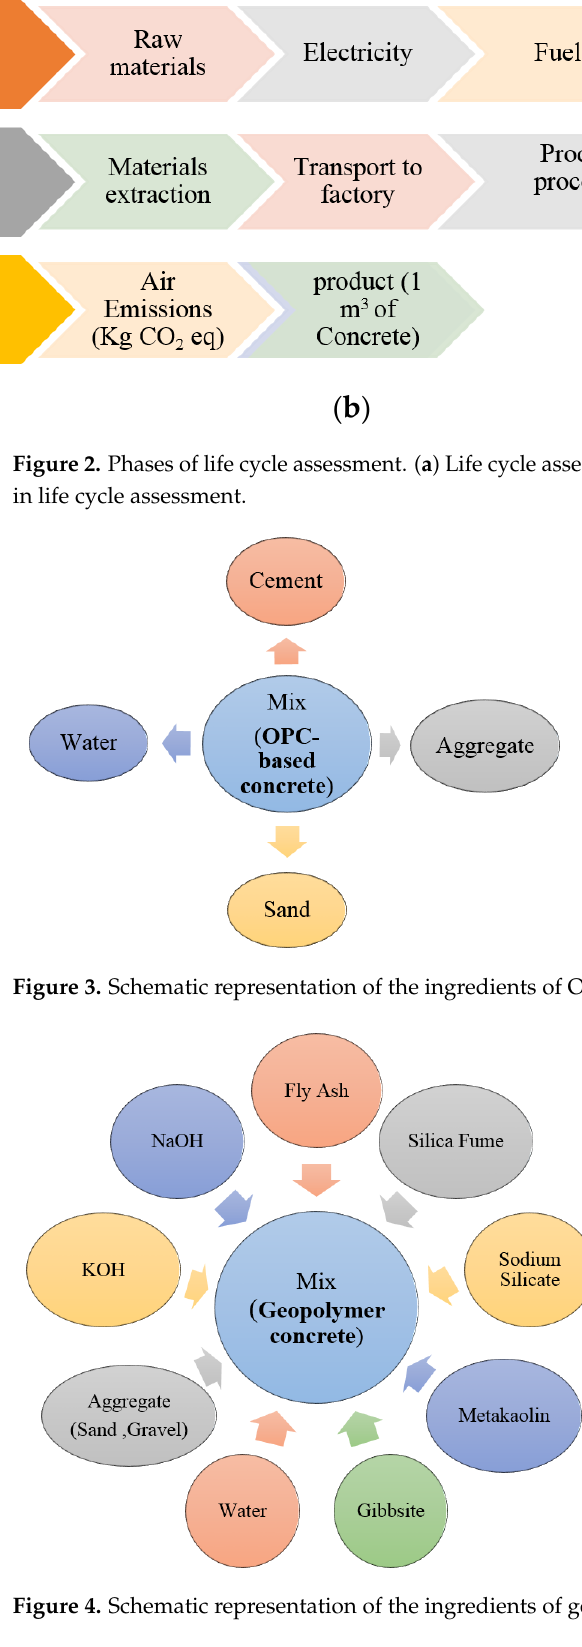
Figure 4. Schematic representation of the ingredients of geopolymer concrete.